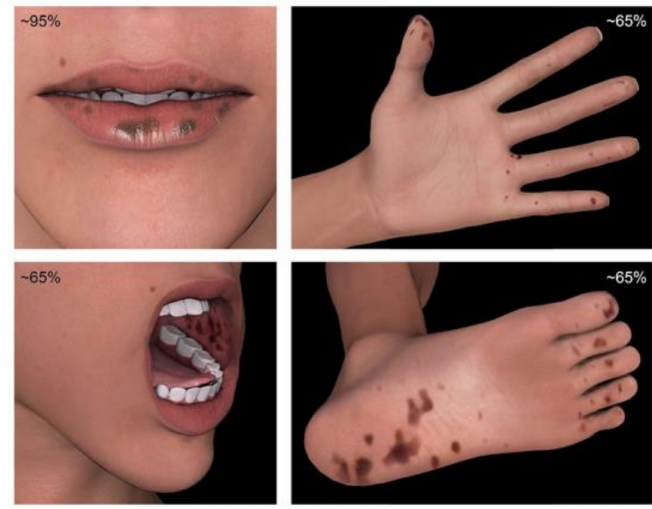
Figure 2. The mucocutaneous pigmentations of